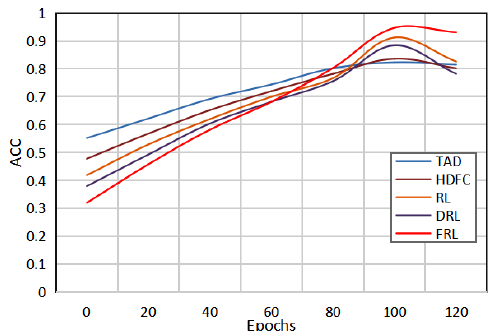
Figure 2. Comparison of the results of the five methods under different epochs.